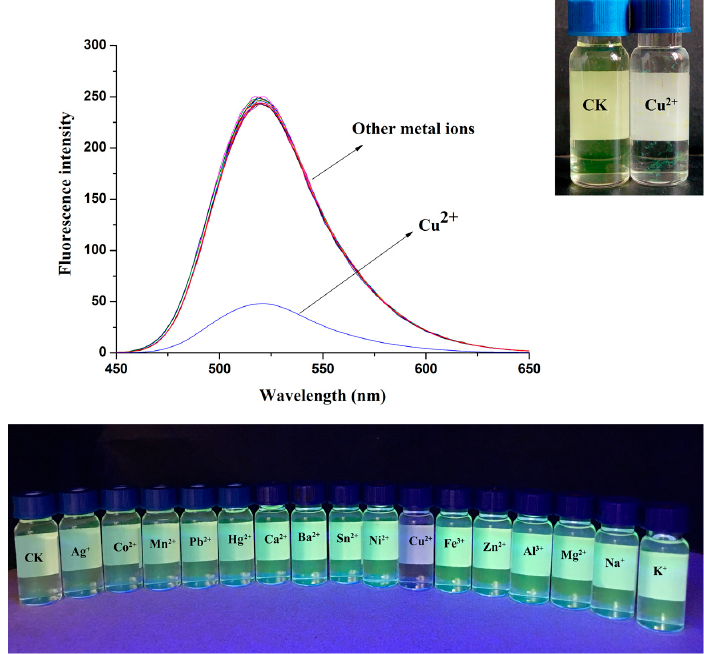
Figure 2. Fluorescence changes of compound L (10 μ M) in the absence (CK) and presence of metal cations (50 μ M) in EtOH/H 2 O (4:1 v / v ).